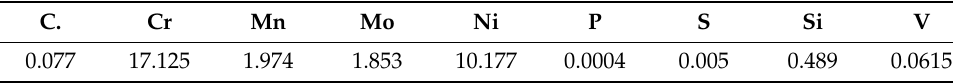
Table 1. Chemical composition for stainless steel 316.